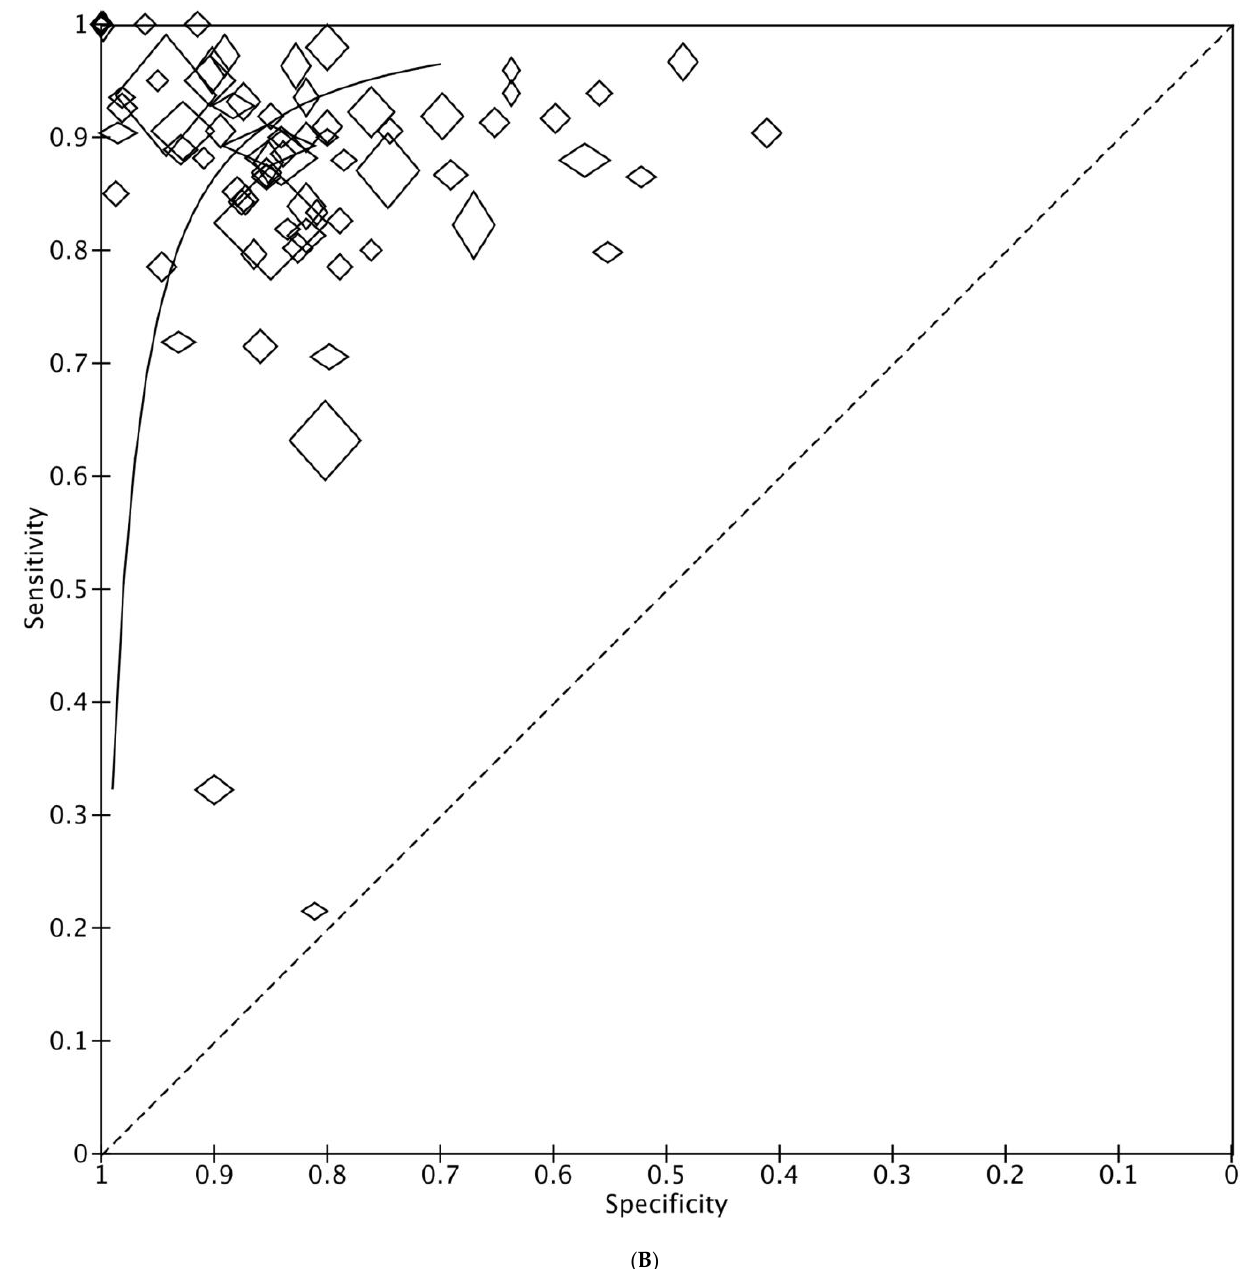
Figure 2. ( A ) Overall sensitivity and specificity of radiomics. ( B ) Receiver operating characteristic (ROC) curve of malignant versus benign thyroid nodules based on radiomic analyses.